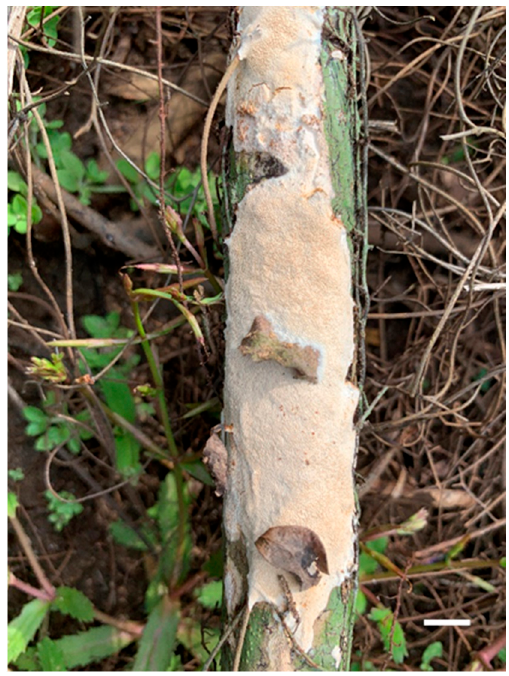
Figure 9. Basidiocarp of Haploporus srilankensis (Holotype). Scale bar = 1.0 cm. MycoBank: